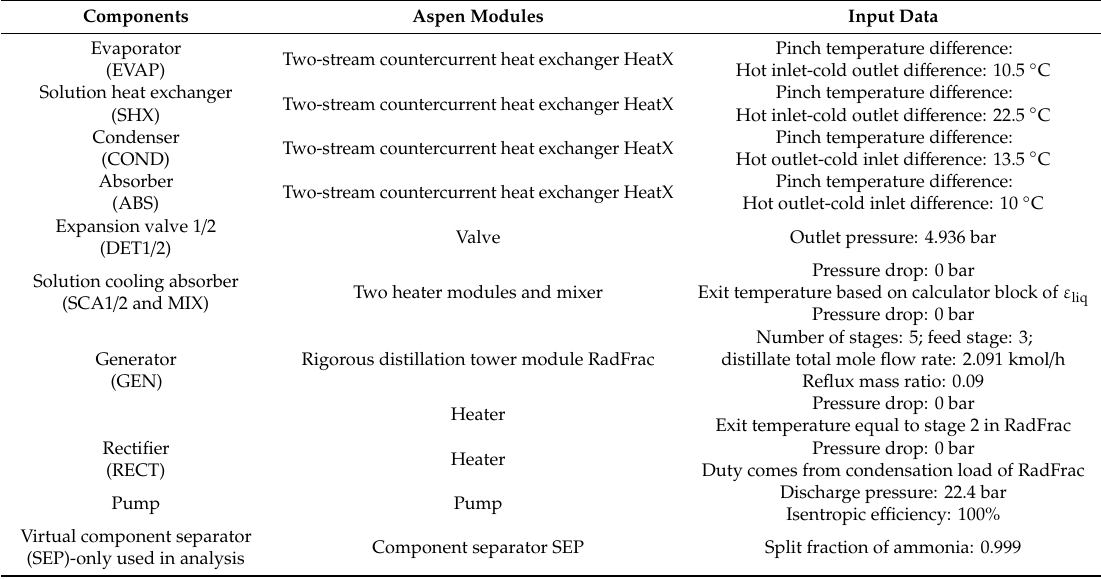
Table 2. Components and their corresponding modules with input